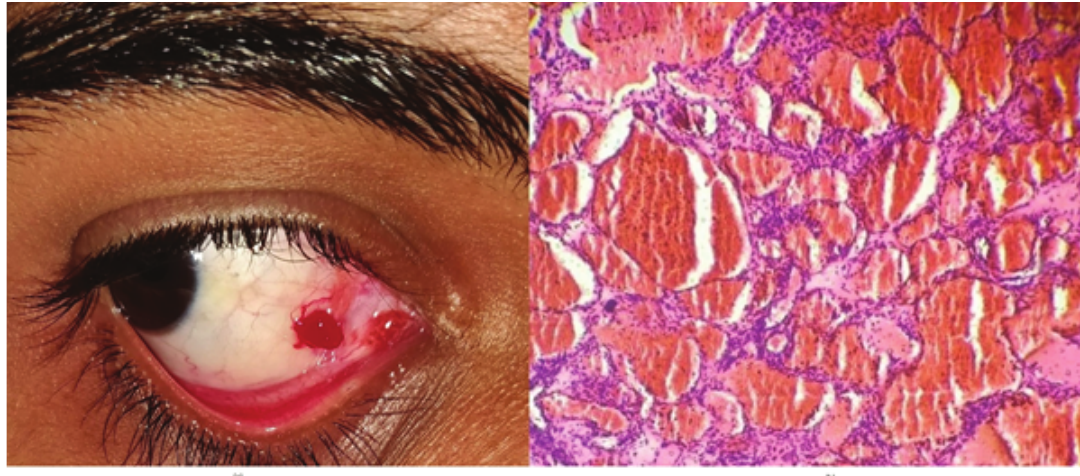
Figure 1. (a) Image showing a bright red, smooth, lobulated mass on the nasal side of the bulbar conjunctiva with tortuous conjunctival vessels at its base. (b) Histopathological evaluation of the lesion showing multiple, blood-filled cavernous spaces surrounded by a fibromyxoid stroma (hematoxylin and eosin, 10 × magnification).